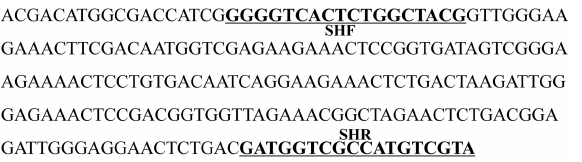
FIGURE 2 | Nucleotide sequence of the SCoT marker specific to D. officinale . The sequence was named SCoT13-215, and has been deposited in GenBank (Accession number: MN746373), the underlined bold sequences represent the forward primer (SHF) and reverse primer (SHR).